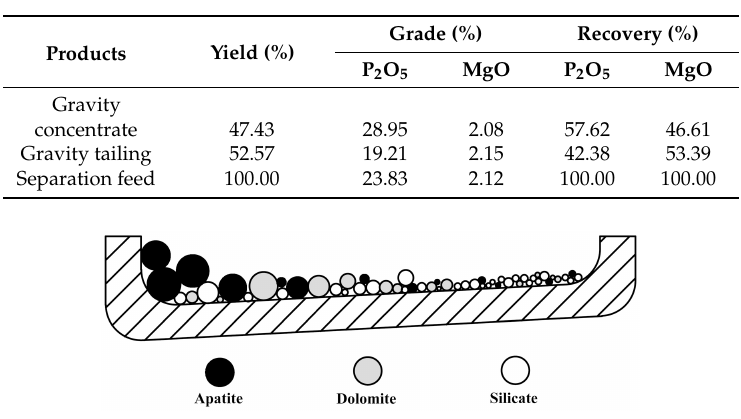
Figure 3. Gravity separation phenomenon.